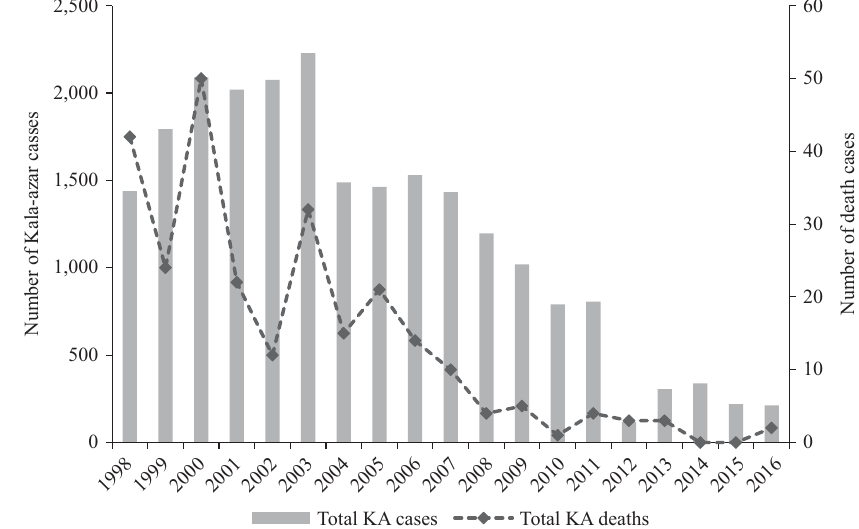
Figure 2. Kala-azar